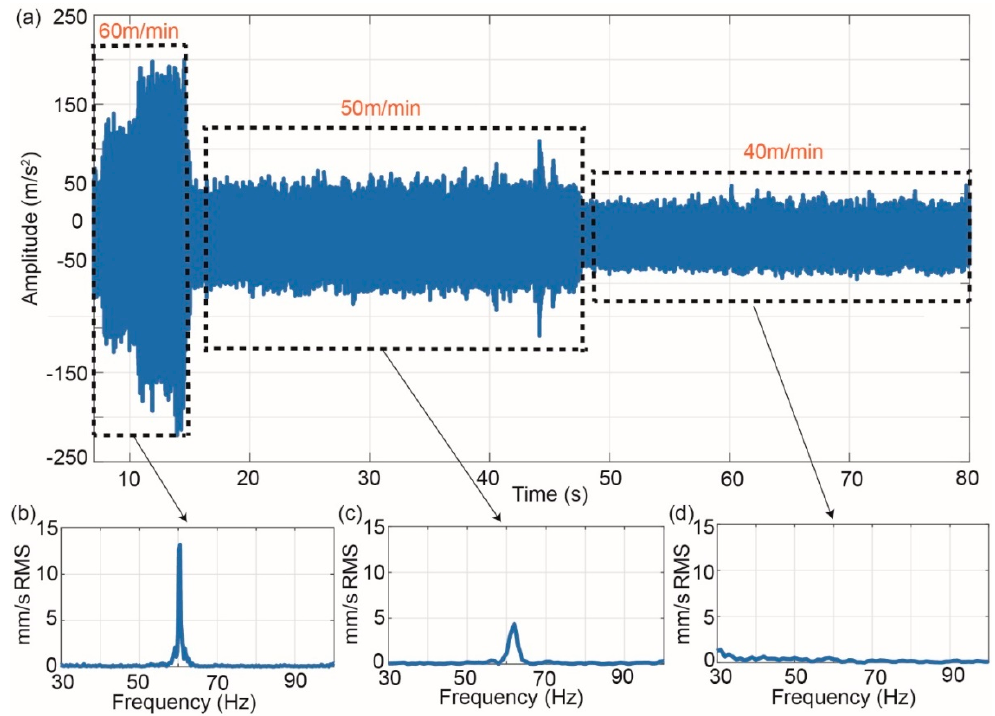
Figure 7. ( a ) Time signal of the test and vibration spectrum at different spindle speeds: ( b ) 60 m/min; ( c ) 50 m/min; ( d ) 40 m/min.